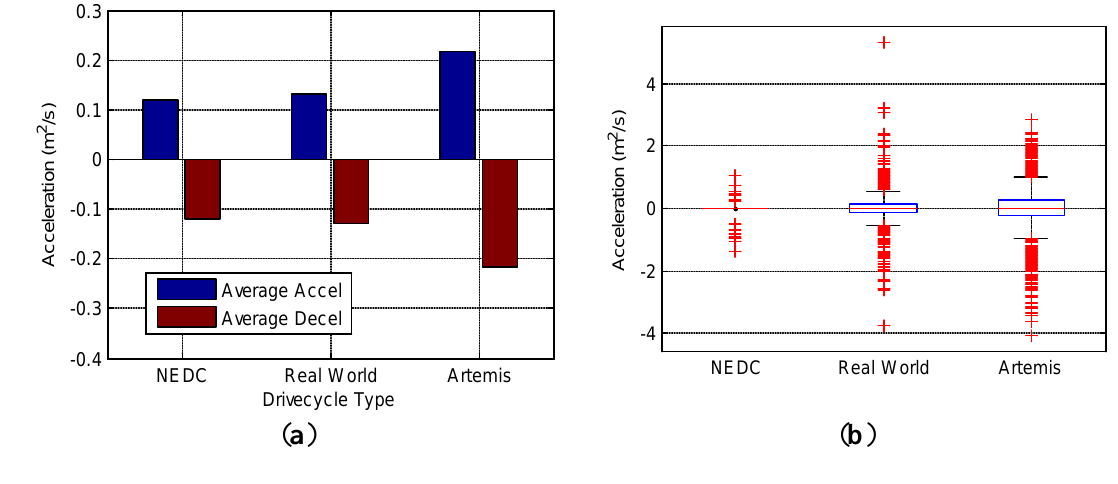
Figure 11. Analysis of accelerations in each drive cycle: ( a ) average accelerations; and ( b ) spread of acceleration occurrences.